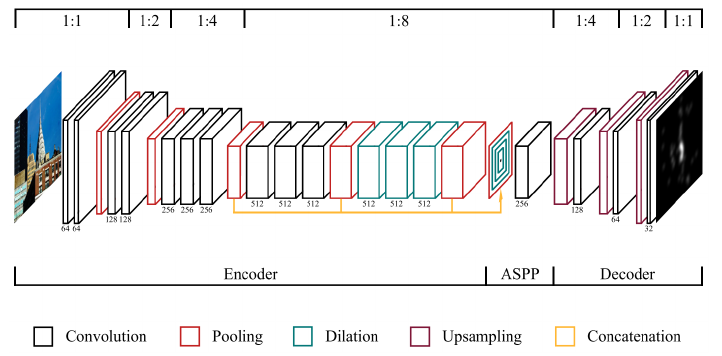
Figure 5. Architecture of MSI-Net [19]. The encoder module extracts the multiscale features with multiple convolutional layers, and the decoder module produces the predicted saliency map.